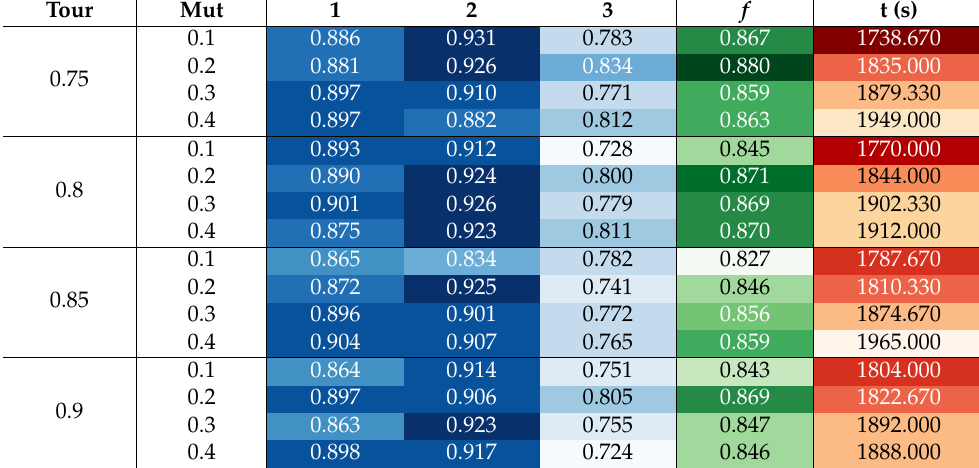
Table A4. Calibration results for map 519. Colored columns show fitness averages for each step (identified by step number), average over all steps ( ¯ f ), and runtimes (in seconds). Each row is a combination of two parameters: tournament probability (tour) and mutation rate